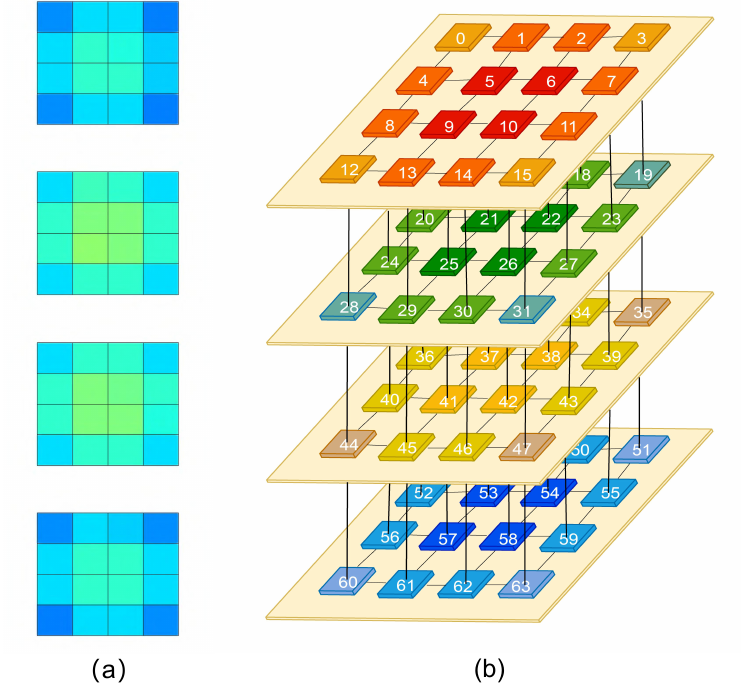
Figure 3. ( a ) Static traffic load distribution under random traffic pattern. ( b ) Architecture after